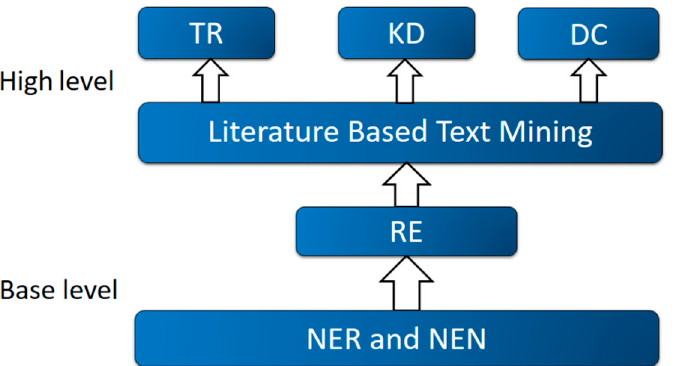
Figure 2. Flow chart of a typical text-mining system. Literature mining systems can be roughly divided into base level and high level. At the base level, there are three important tasks, including named entity recognition (NER), named entity normalization (NEN) and relation extraction detection (RE). Topic recognition (TR), knowledge discovery (KD) and database curation (DC) are handled at the high level.